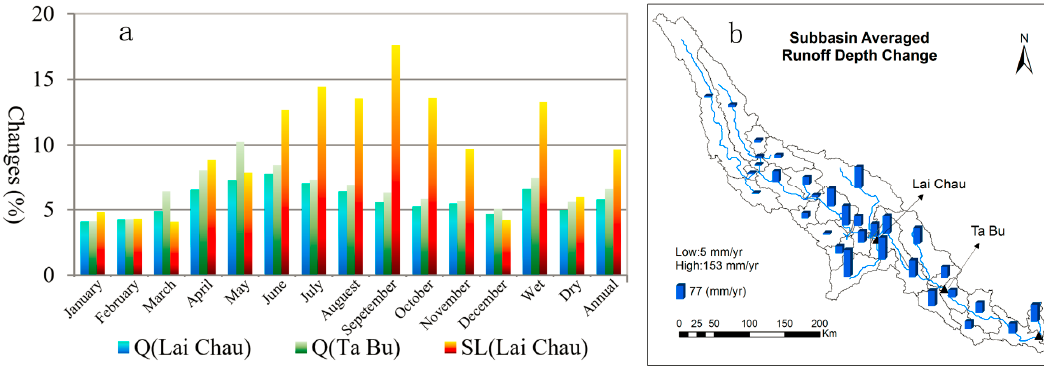
Figure 7. ( a ) Annual distribution changes in streamflow and sediment load under land cover change scenario at the Lai Chau and Ta Bu ( b ) Spatial distribution of averaged annual runoff depth change. Table 5. Water balance changes due to land cover change between year of 2001 and 2050: Precipitation (P, mm), actual evapotranspiration (AET, mm), surface runoff (SR, mm), ground water (GW, mm), total runoff (TR, mm).